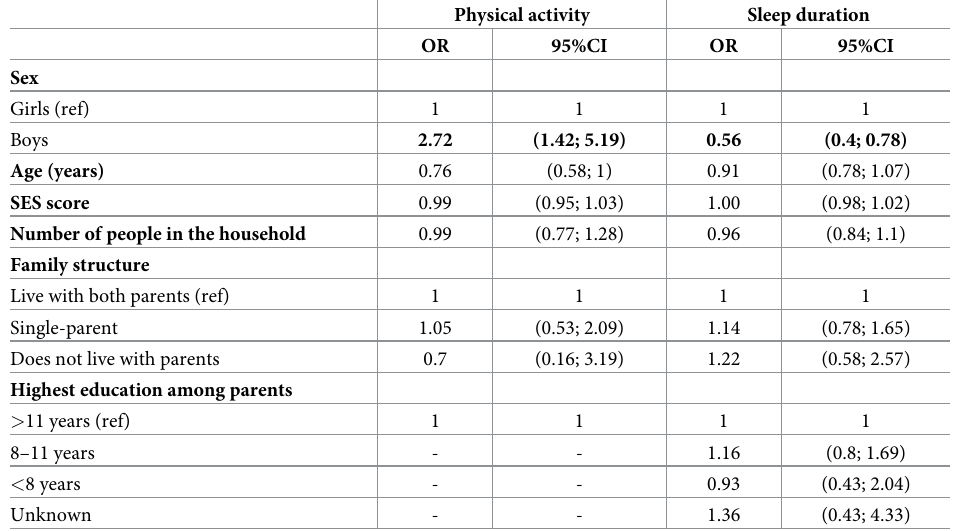
Table 4. Sociodemographic correlates of meeting the physical activity and sleep duration guidelines using acceler- ometer data. (n = 688